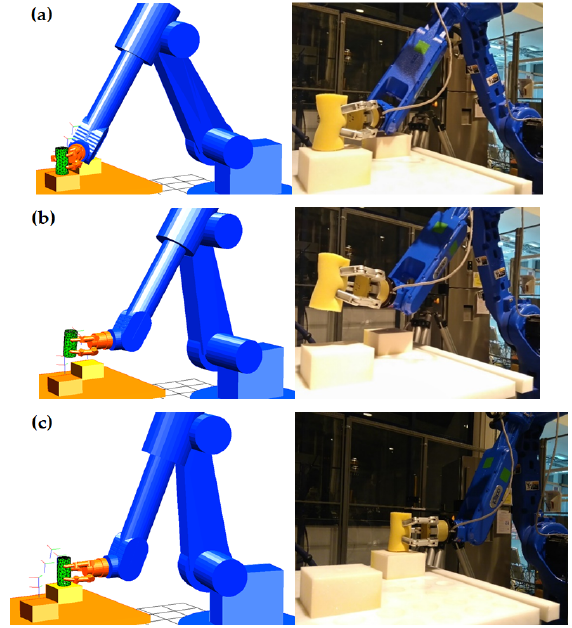
Figure 12. Pick-and-place of a cylinder by the Adept robot and the Barrett hand: ( a ) grasping, ( b ) lifting, and ( c )